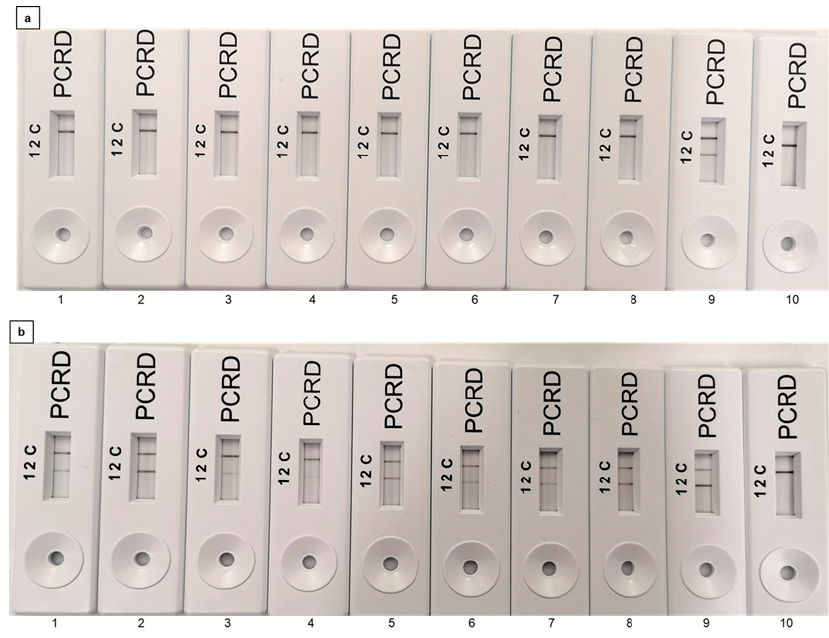
Figure 3. PMAxx-recombinase polymerase assay-lateral flow assay (RPA-LFA) for serially diluted dead E. coli O157:H7. ( a ) Targeting the rfbE gene; ( b ) targeting the stx gene. From left to right (LFA 1-8), the concentrations of dead E. coli O157:H7 were 10 8 CFU mL − 1 , 10 7 CFU mL − 1 , 10 6 CFU mL − 1 , 10 5 CFU mL − 1 , 10 4 CFU mL − 1 , 10 3 CFU mL − 1 , 10 2 CFU mL − 1 , and 10 1 CFU mL − 1 , LFA 9: live bacterial